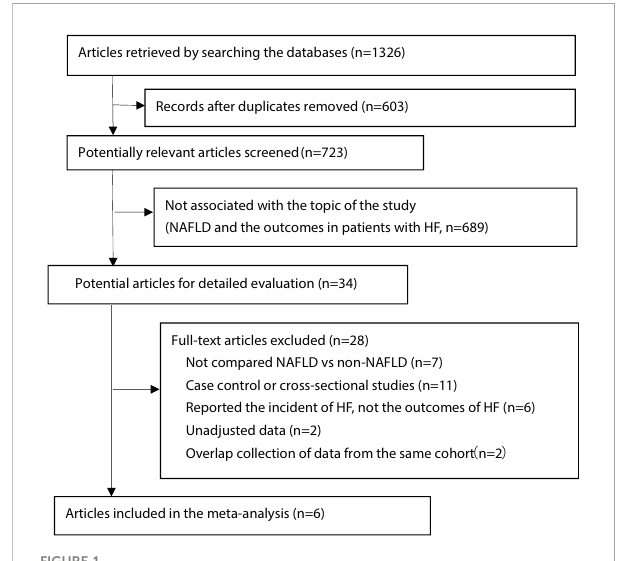
FIGURE 1 Flow of papers through screening and review. HF, heart failure; NAFLD, non-alcoholic fatty liver